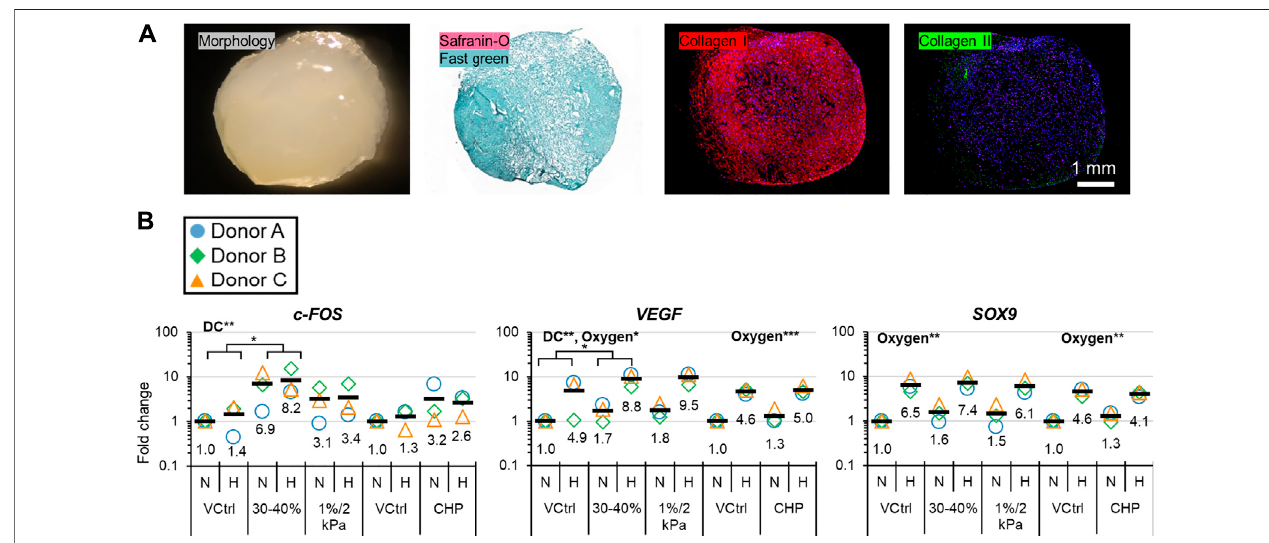
FIGURE2| Experiment I: (A) Representative baseline tissue matrix morphology(3 weekspreculture),and (B) geneexpression inresponseto5-daysofmechano- hypoxia treatment. DC and CHP each had their own VCtrl group since the loading occurred in different chambers. Fold changes are with respect to the appropriate N/ VCtrl group within each donor, and values for each gene of interest are normalized to the mean expression of housekeeping genes β -actin , B2M , and YWHAZ . Expressionwasmeasured30 minafter the fi nalloadingevent. Two-way ANOVA wasperformed twice,oncefor DCand onceforCHP groups. “ DC ” and “ Oxygen ” indicate that these factors had a signi fi cant main effect. *: p < 0.05, **: p < 0.01. CHP, Cyclic hydrostatic pressure; DC, dynamic compression; H, hypoxia/HYP; N, normoxia/NRX; VCtrl, static vehicle control.